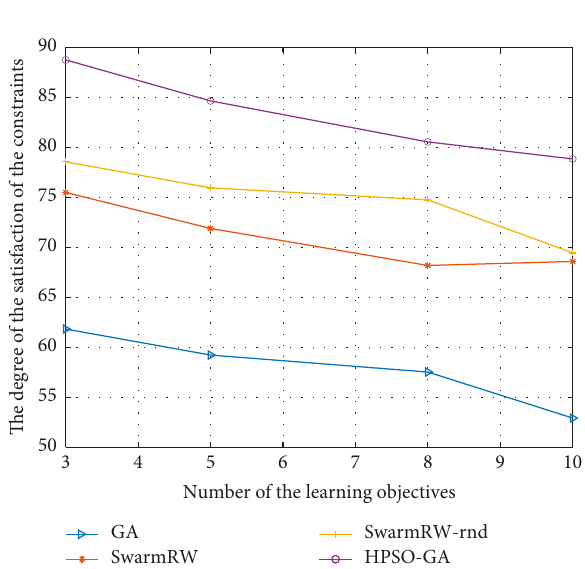
Figure 5: The scalability comparison between HPSO-GA and the peer algorithms with respect to the learning